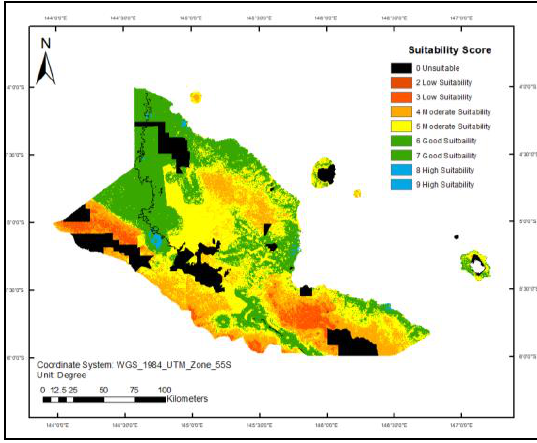
Figure 4. Residential land-use suitability map of general AHP